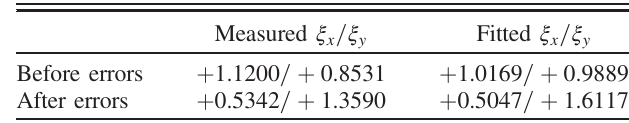
TABLE III. Measured chromaticity and chromaticity of model fitted to measured OEORM. “ Before errors ” refers to the machine at nominal sextupole settings, while “ After errors ” refers to the reductions described in Sec.